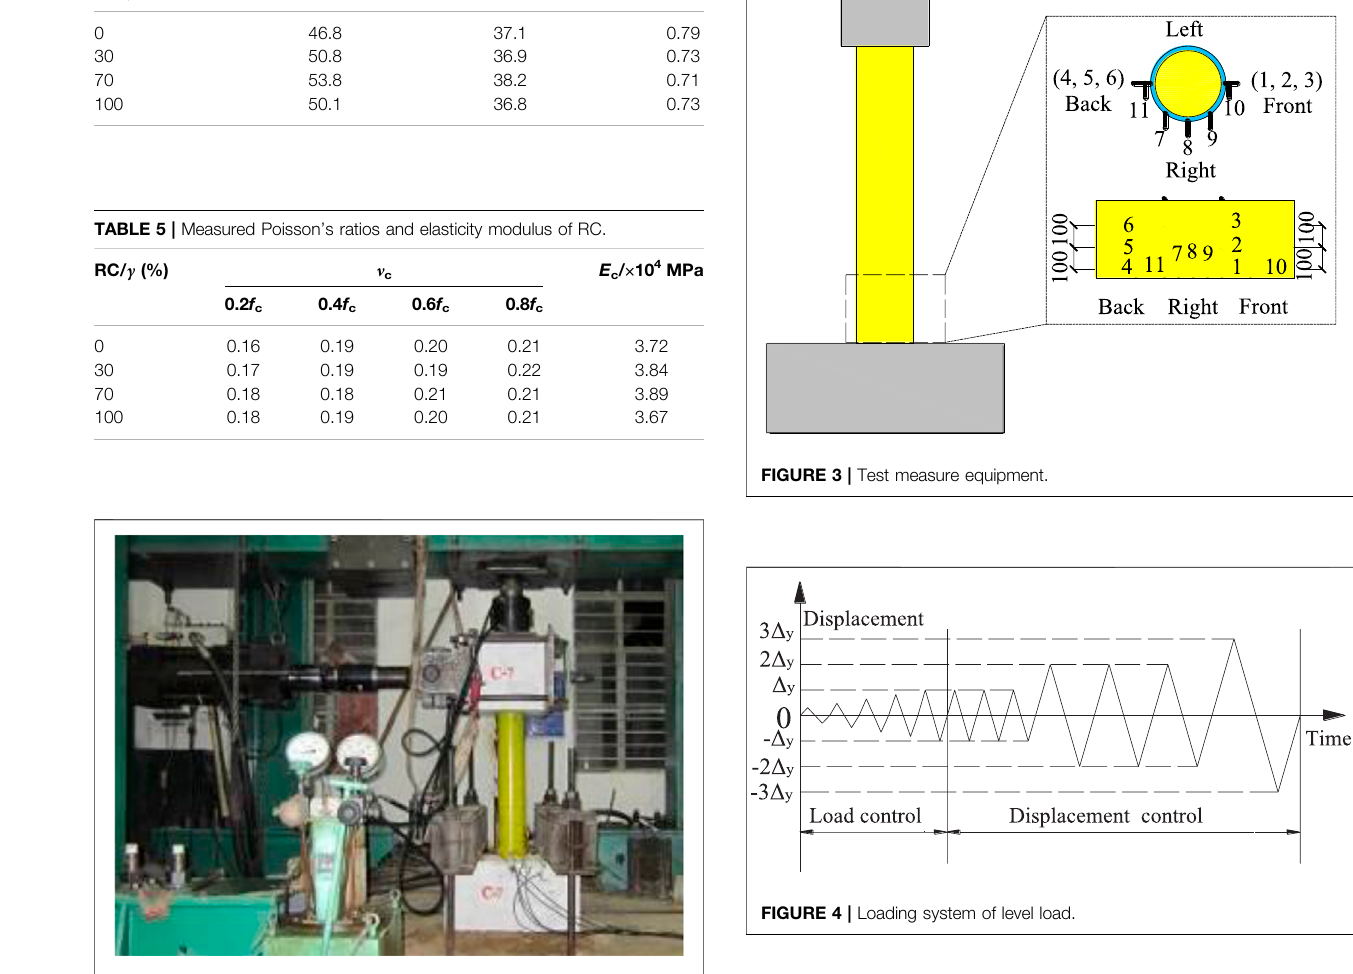
FIGURE 2 | Test setup photo.